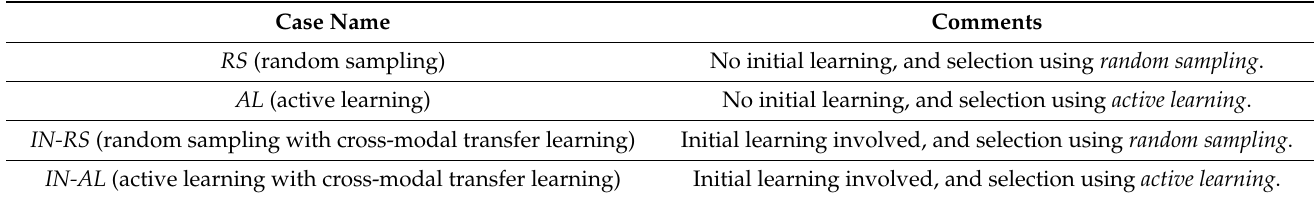
Table 2. The different cases used during the